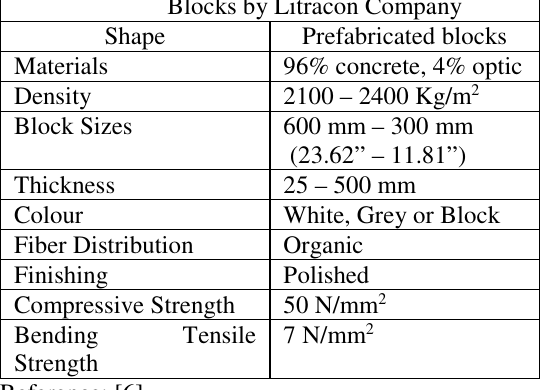
Table 1: Properties of Transparent Concrete Blocks by Litracon